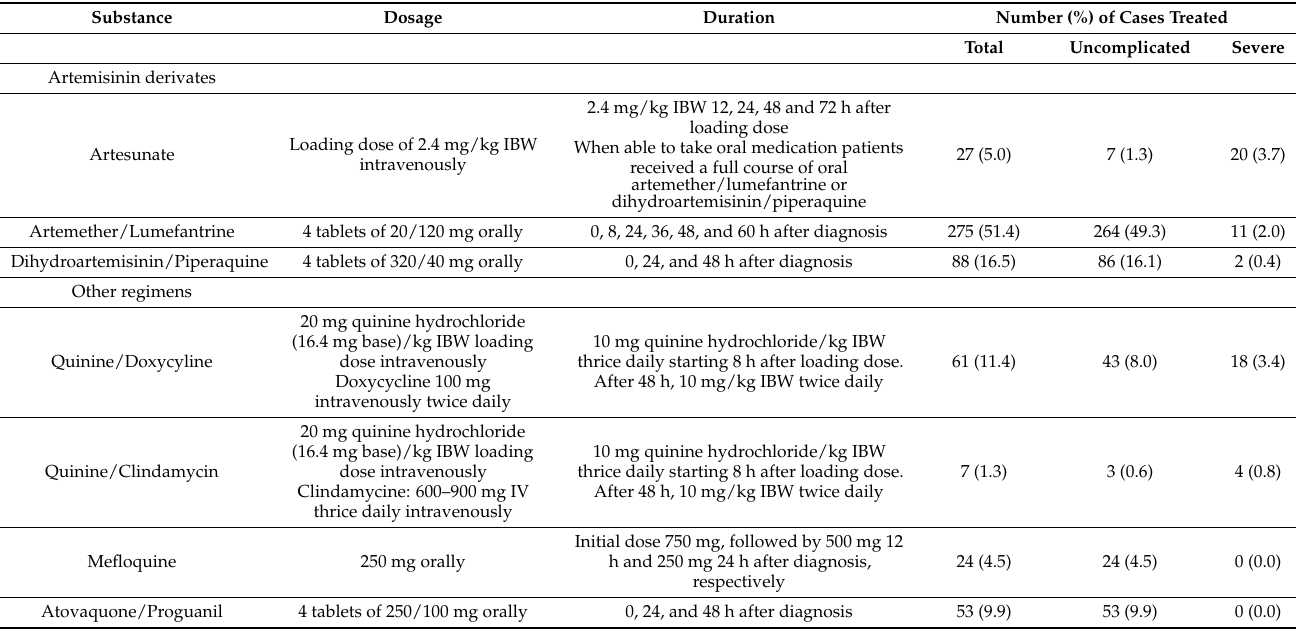
Table A1. Antimalarial therapy in 535 adult imported falciparum malaria cases treated in the Department of Infectious Diseases and Pulmonology of the Charit é University Hospital, Berlin,